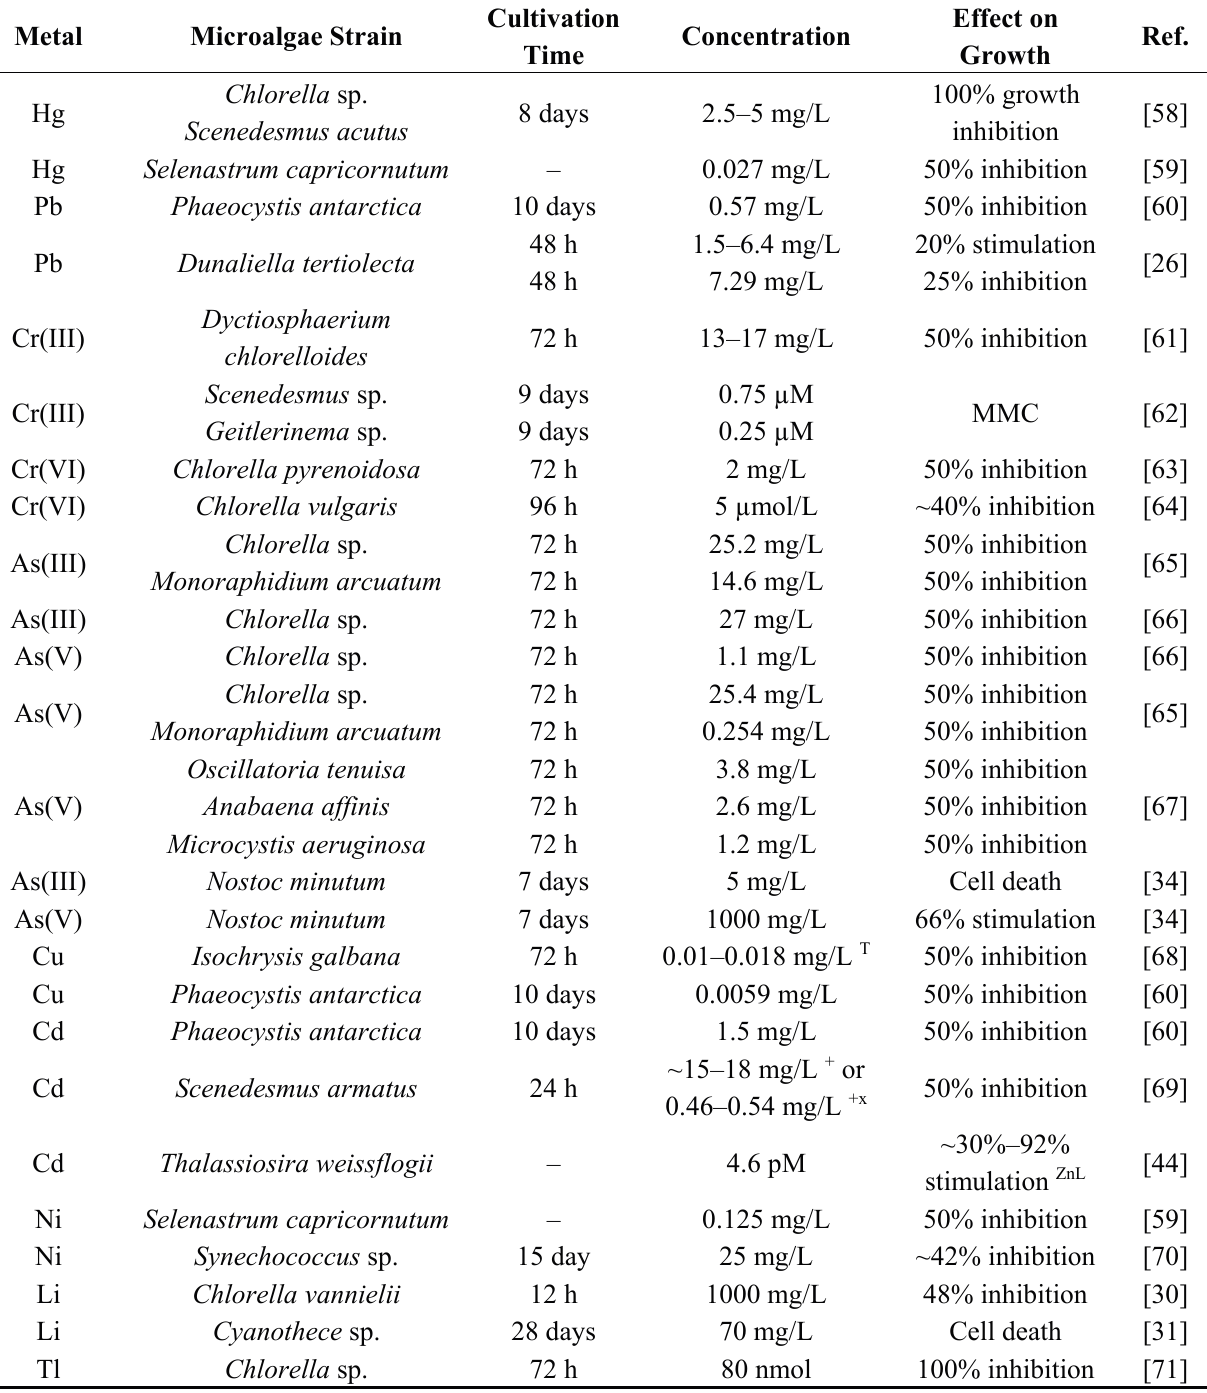
Table 1. Effect of metals, metalloids and metallic nanoparticles on growth of